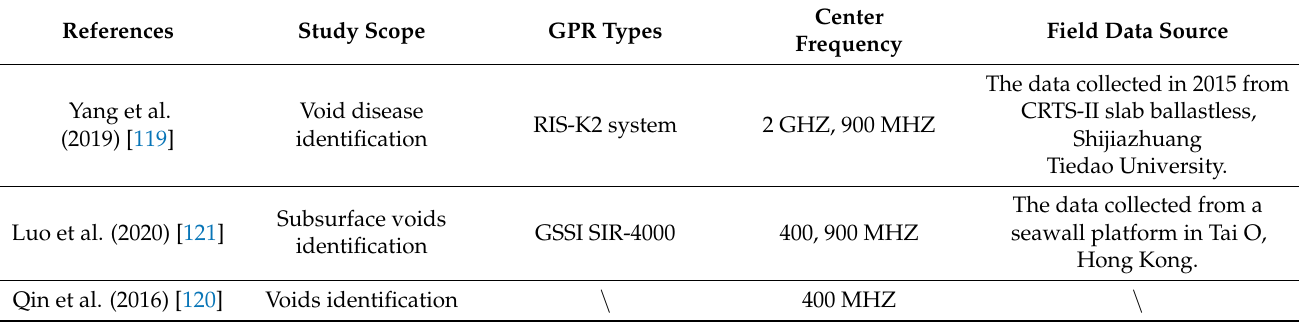
Table 4. Some examples of the latest GPR works in urban risk